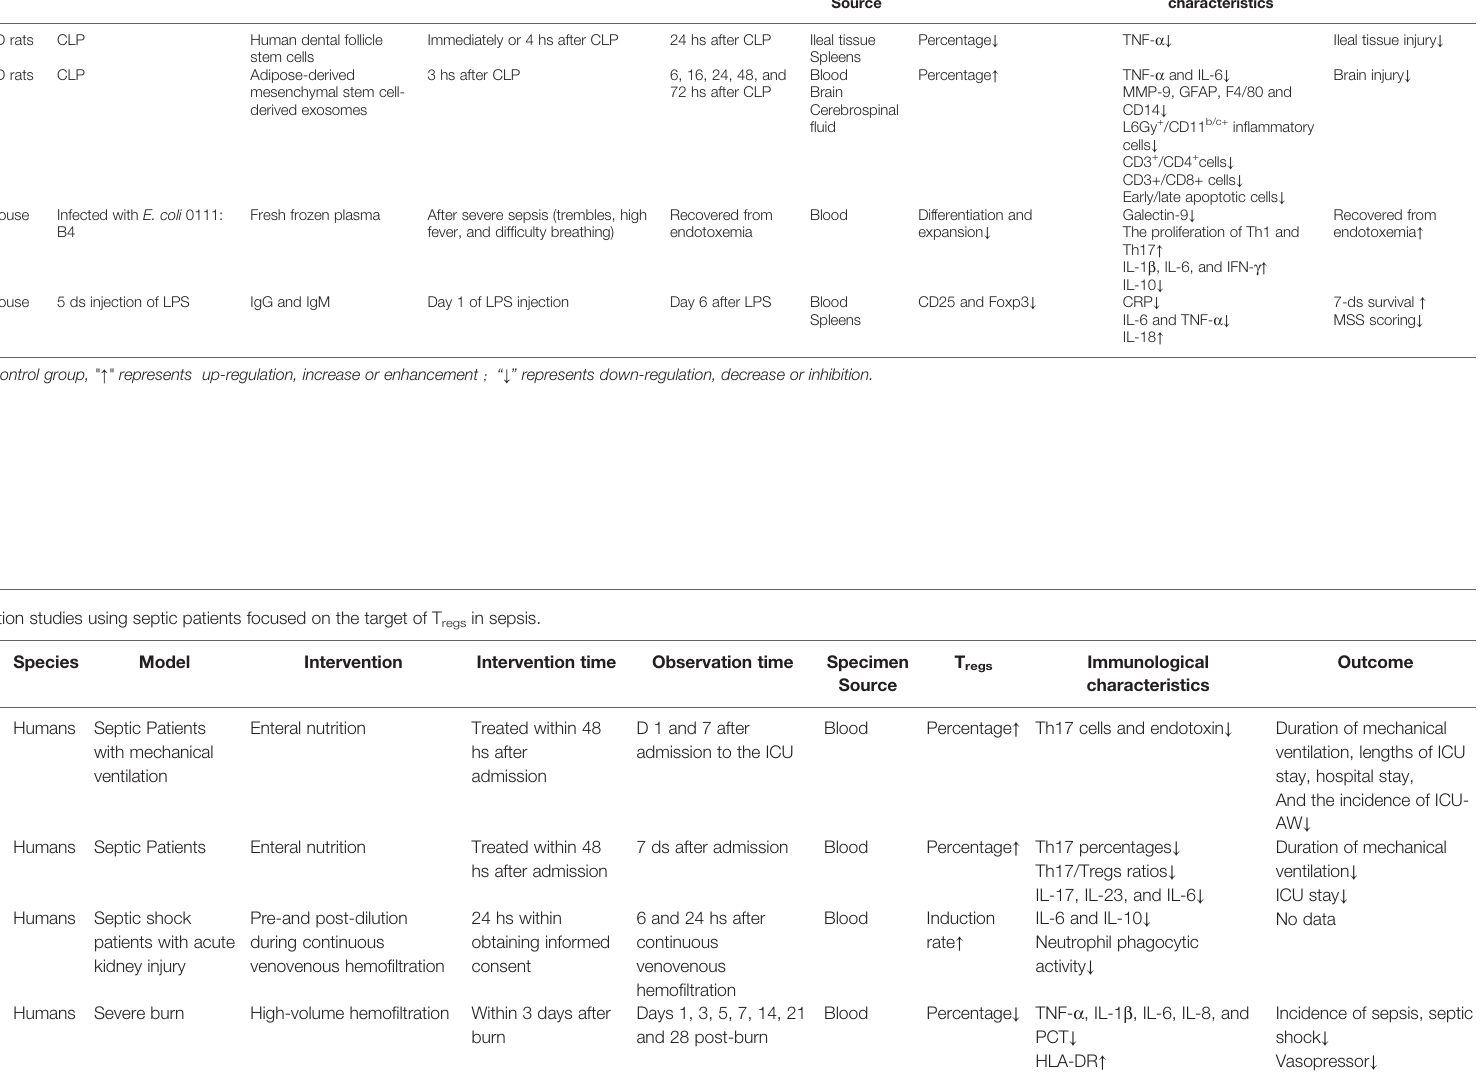
Chihara, et al. (119) Humans Septic shock